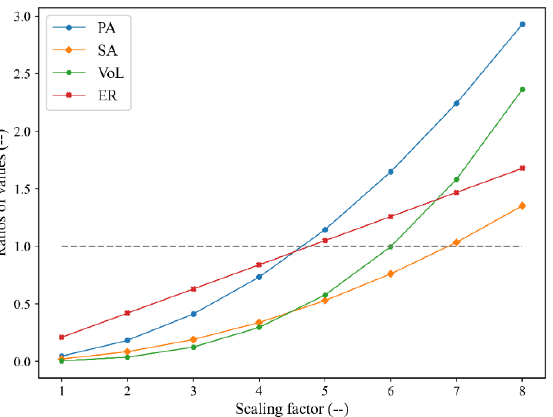
Figure 19. Ratios of values between d 50 related to convex pattern related (PA: projected area, SA: surface area, Vol: volume, ER: equivalent radius).